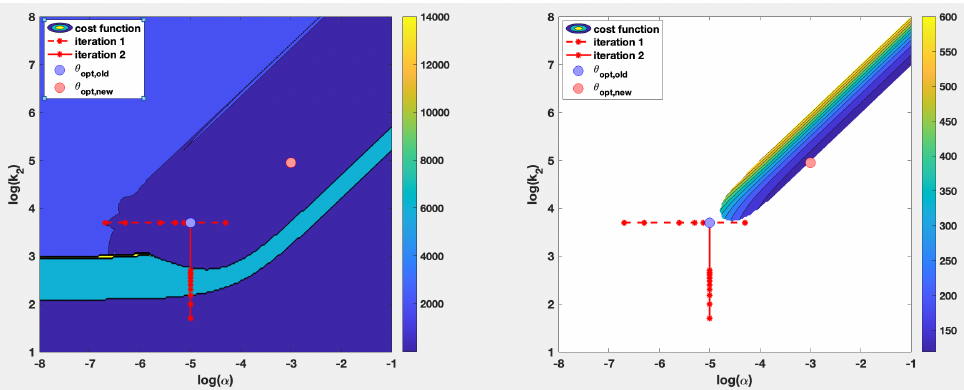
Figure 7. The evolution of the cost function f u , ε in terms of α and k 2 with ( right ) and without ( left ) considering the feasible region, along with the location of the sub-optimal solution (red circle), the location of the solution obtained based in the ad hoc analysis (purple circle), and the two iterations used in the ad hoc analysis (dotted red and red